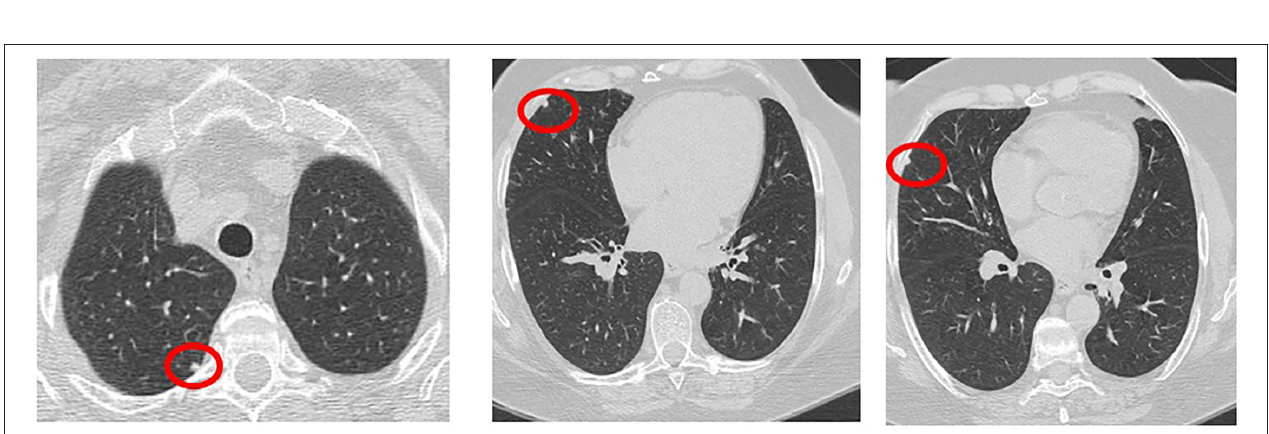
FIGURE 4 | Multiple pulmonary nodules on HRCT in a patient with RA.